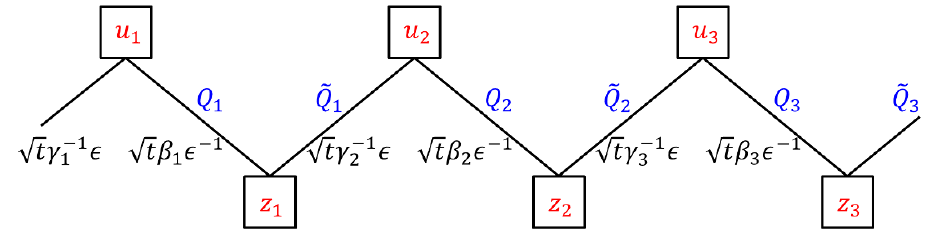
Figure 20 . The free trinion in the case of k = 3. All the groups are of SU(2) symmetry, the (cid:12) and (cid:13) charges are under the Cartan of SU( k ) (cid:12) (cid:2) SU( k ) (cid:13) internal symmetry, and the t charge is under the U(1) t internal symmetry. The fugacity (cid:15) corresponds to the minimal puncture U(1) symmetry. The quiver is a circular one as the left and right edge are implicitly connected. The moment map operators for the maximal punctures are M i = Q i e Q i for the u puncture and M 0 z puncture. The moment maps for the minimal punctures are the 2 k baryons Q 2